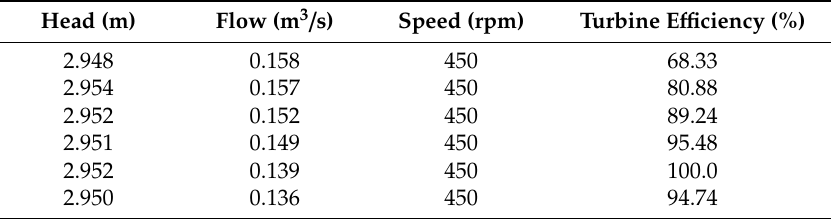
Table 4. E ffi ciency measurement at rated head and rated speed.